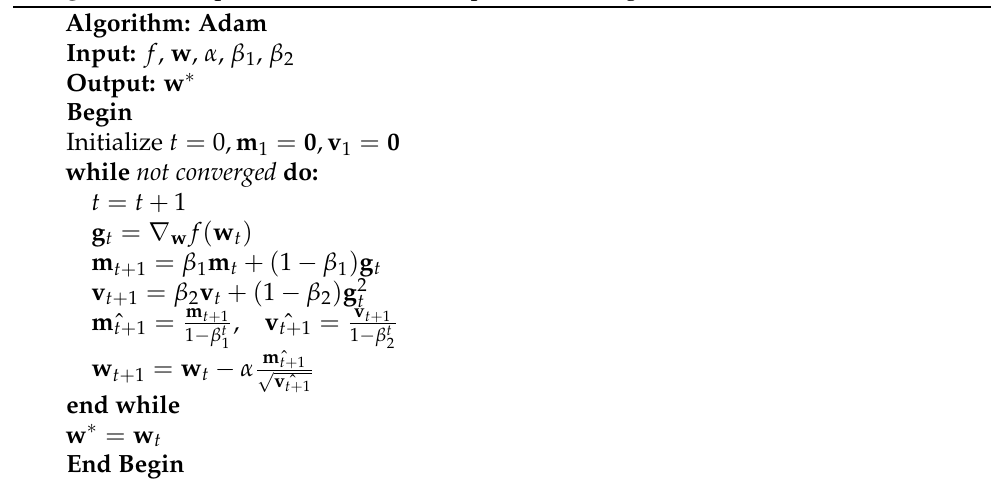
Algorithm 1: A pseudocode of Adam optimization